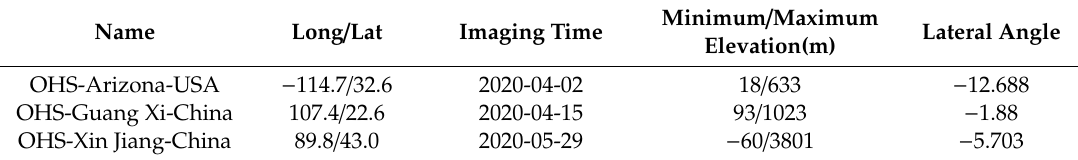
Table 2. Image registration experiment data.